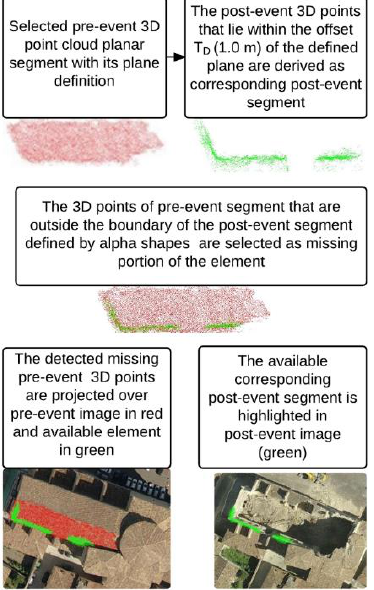
Figure 3. Overall workflow of segment-based